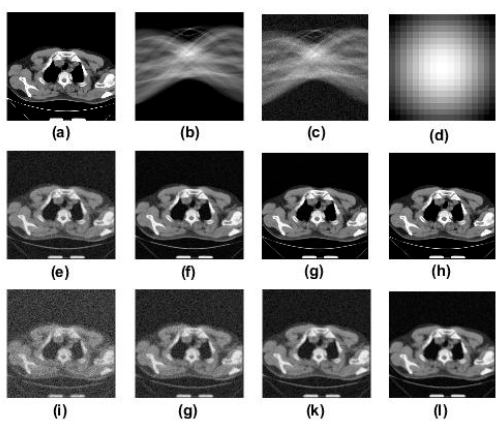
Figure 3. Experimental images and results of the third CT image. The 1st row shows the sharp CT image (left) and the CT noisy projection for 100% of measurements (middle) as well as the 18 × 18 point spread function; the 2nd row shows the blind restoration reconstruction results for 40%, 60%, 80% and 100% of measurements, respectively, from left to right (SNR = 40 dB); the 3rd row shows the blind restoration reconstruction results for 40%, 60%, 80% and 100% of measurements, respectively, from left to right (SNR = 20 dB). ( a ) the sharp CT image; ( b ) the measured noisy projection (SNR = 40 dB); ( c ) the measured noisy projection (SNR = 20dB); ( d ) the point spread function; ( e ) the reconstruction result (SNR = 40 dB, Sampling ratio = 40%); ( e ) the reconstruction result (SNR = 40 dB, Sampling ratio = 60%); ( f ) the reconstruction result (SNR = 40 dB, Sampling ratio = 80%); ( g ) the reconstruction result (SNR = 40 dB, Sampling ratio = 100%); ( h ) the reconstruction result (SNR = 20 dB, Sampling ratio = 40%); ( i ) the reconstruction result (SNR = 20 dB, Sampling ratio = 60%); ( j ) the reconstruction result (SNR = 20 dB, Sampling ratio = 80%); ( k ) the reconstruction result (SNR = 40 dB, Sampling ratio = 40%); ( l ) the reconstruction result (SNR = 20 dB, Sampling ratio = 100%). Algorithms 2019 , 12 , x FOR PEER REVIEW